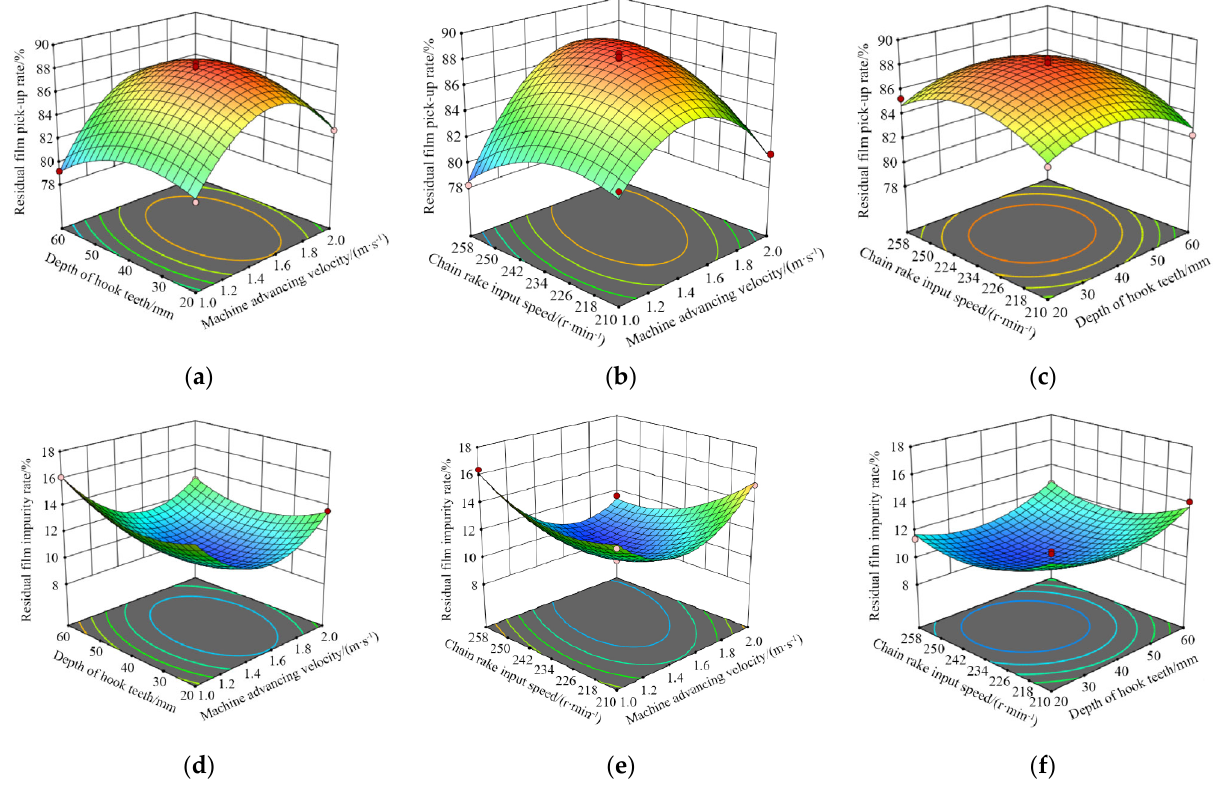
Figure 13. The effects of the interaction of various factors on the picking rate and trash content of cotton fallen on the ground. ( a ). μ 1 = ( X 1 , X 2 , 234); ( b ). μ 1 = ( X 1 ,40, X 3 ); ( c ). μ 1 = (1.5, X 2 , X 3 ); ( d ). μ 2 = ( X 1 , X 2 , 234); ( e ). μ 2 = ( X 1 , 40, X 3 ); ( f ). μ 2 = (1.5, X 2 , X 3